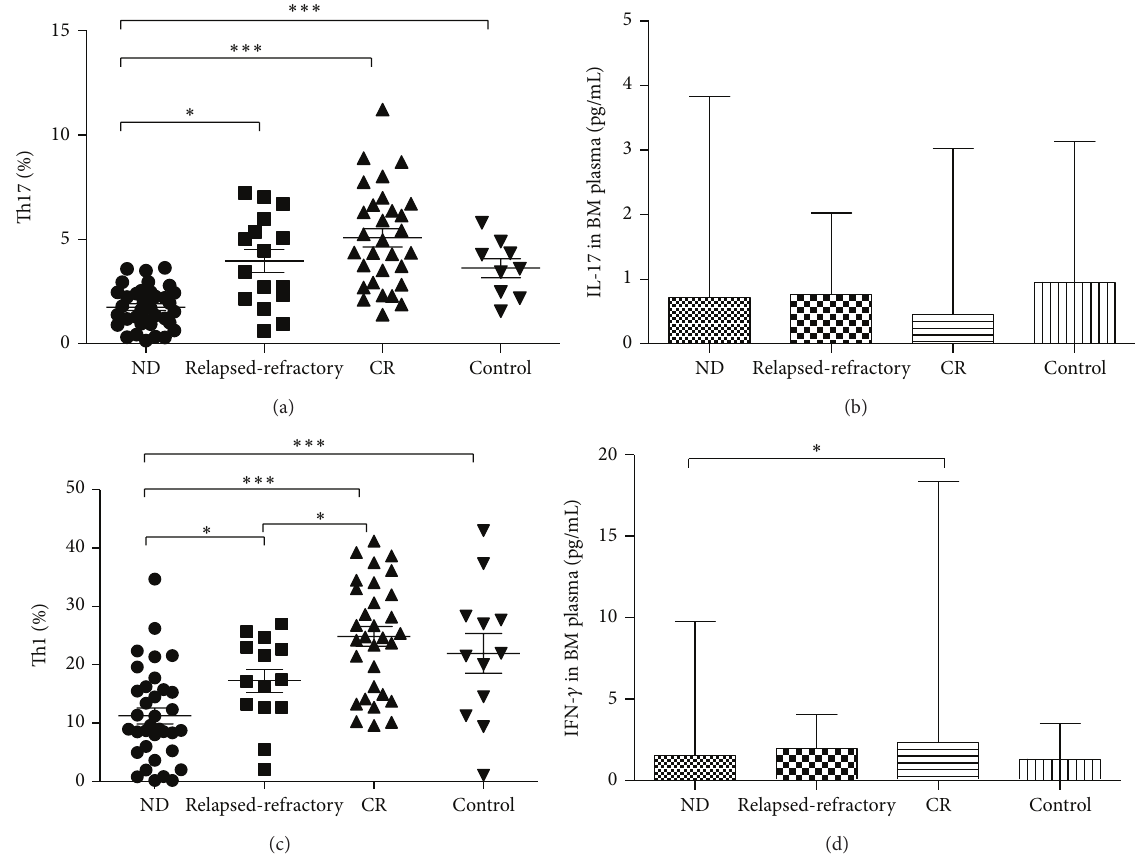
Figure2:ThsubsetsandtheirrelatedcytokinesinND,relapsed-refractory,andCRAMLpatientsandcontrols.(a)ThepercentageofBMTh17 cells was significantly decreased in ND AML patients compared with CR patients or controls after stimulation with phorbol myristate acetate, ionomycin, and monensin for 4 h. (b) The level of BM plasma IL-17A showed the decreased trend in the ND, relapsed-refractory, or CR AML patients compared with controls, though no statistical significance exists. (c) The percentage of BM Th1 cells was significantly decreased in ND AML patients compared with relapsed-refractory or CR patients or controls. (d) The level of BM plasma IFN- 𝛾 was decreased in the ND AML patients compared with CR